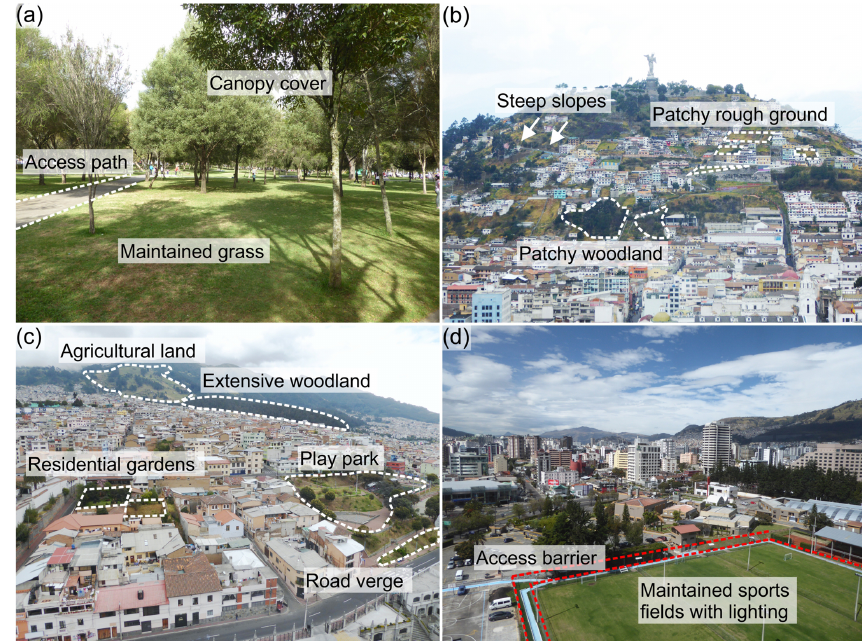
Figure 7. Examples of greenspace in Quito from photographs taken in October 2019 (a–d) .